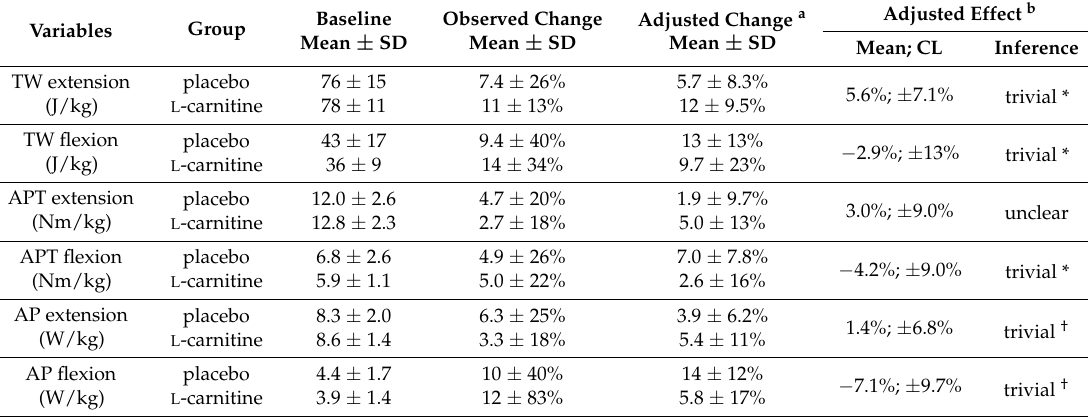
Table 4. Isokinetic measures for the dominant leg at baseline, and changes across a supplementation period in both